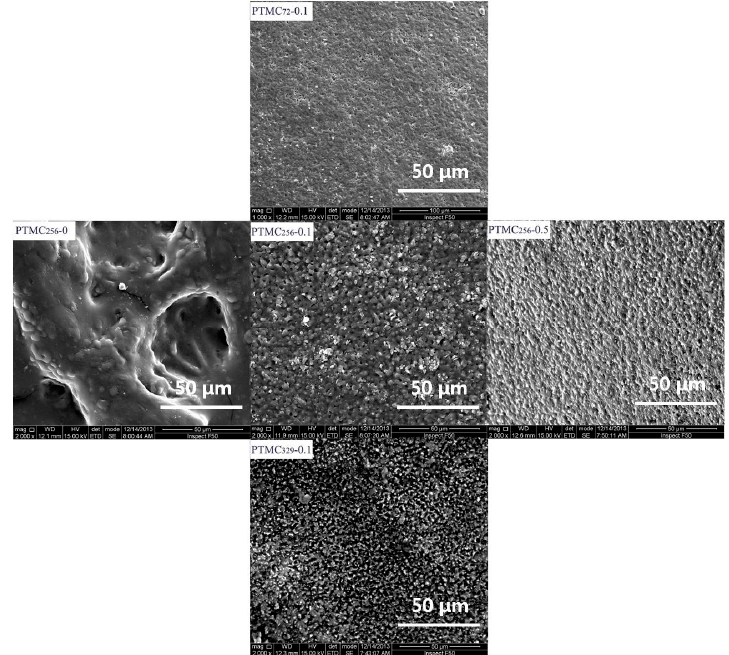
Figure 6. SEM micrographs of the PTMC-Ns surface with different cross-linker amount (Rank) and different initial molecular weight (Column) after four weeks degradation in lipase solution.